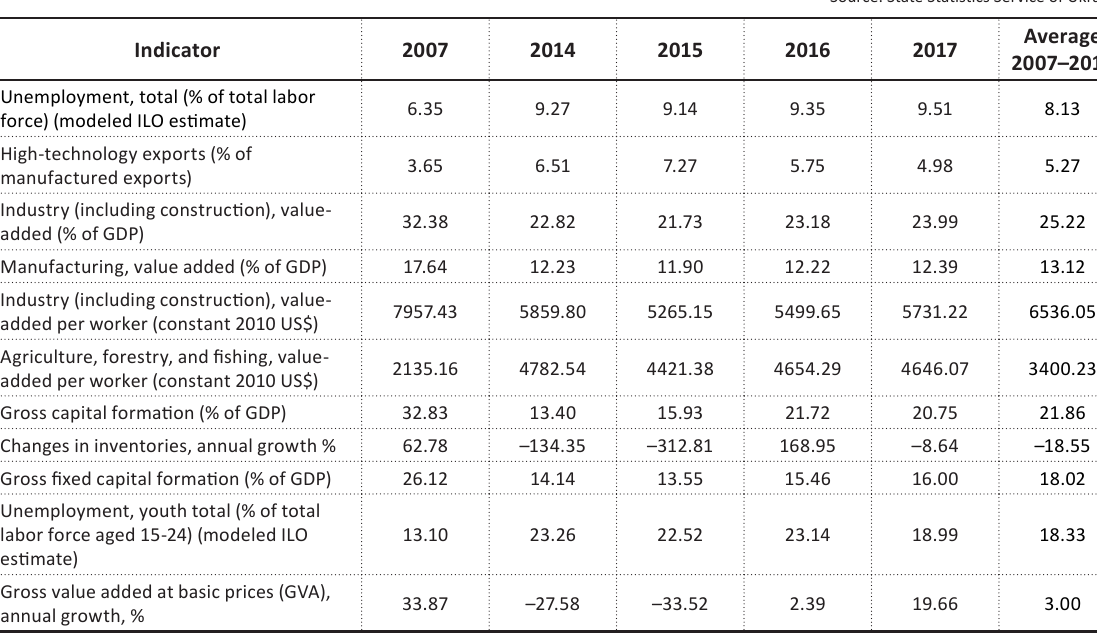
Table 2. Dynamics of indicators characterizing the economic potential of the territories of